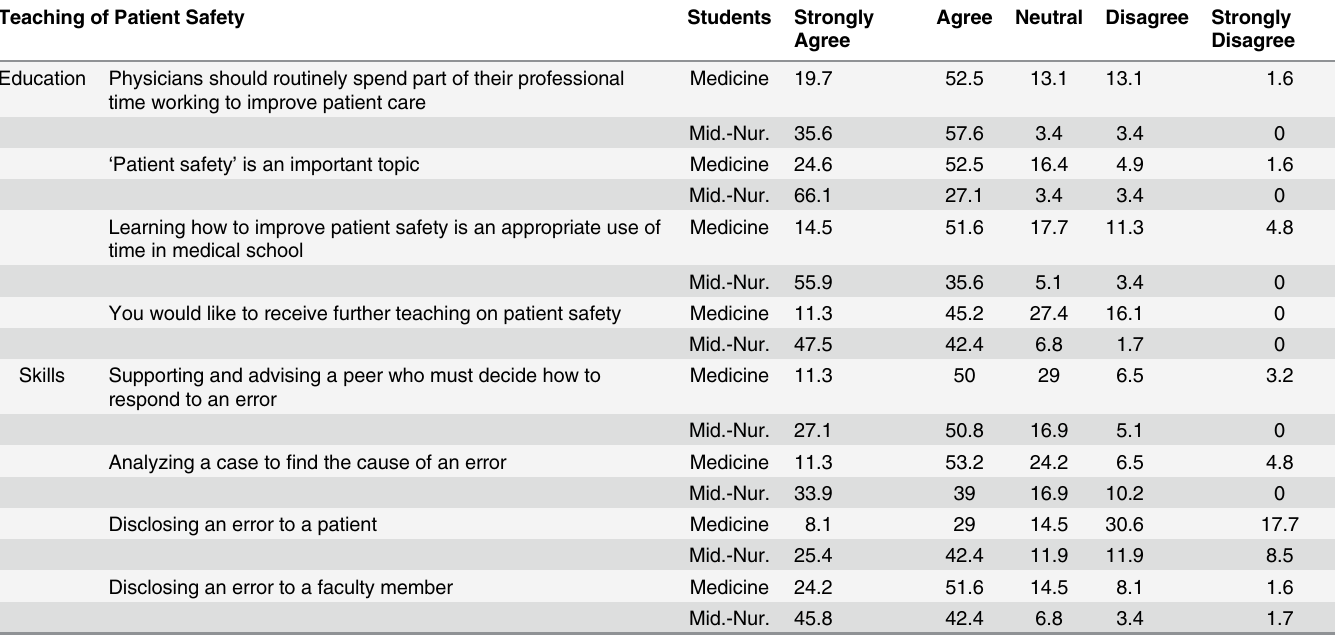
Table 3. Student's Responses to Teaching Items of Patient Safety (n =